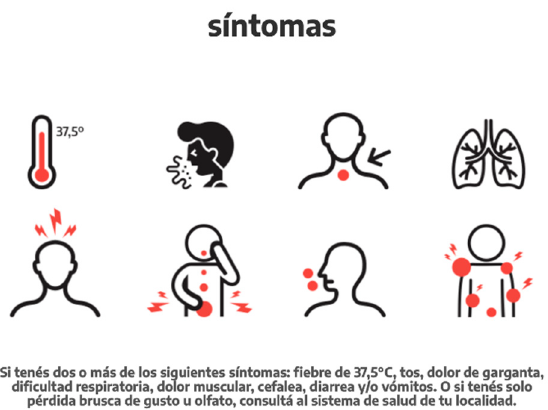
Figure 11. Infographic of COVID-19 symptoms provided by the national government [37].